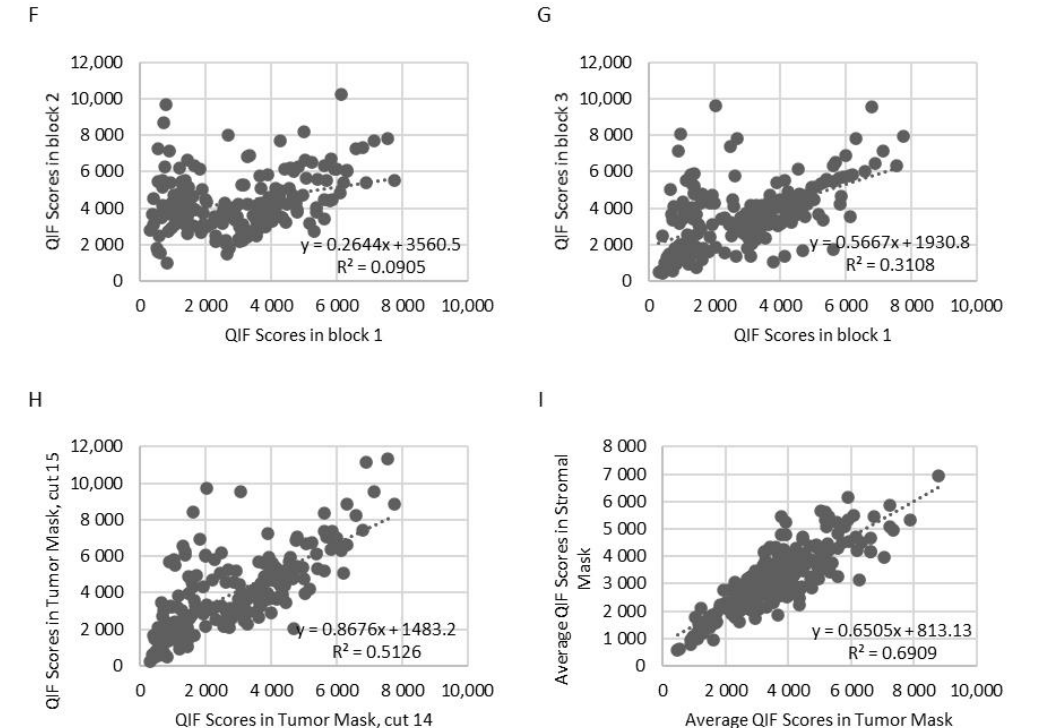
Figure 1. Patterns of expression and distribution of CD200 in lung cancer. ( A , B ) Dynamic range charts that depict CD200 expression within the tumor compartment in non-small cell lung cancer (NSCLC) ( A ) and large cell neuroendocrine carcinoma (LCNEC) ( B ) patients. Red lines represent the visual cutoffs that were used to define CD200 positive cases. ( C – E ) Different cores from the same representative NSCLC case, stained in YTMA423 blocks 1 ( C ), 2 ( D ) and 3 ( E ). ( F – I ) Scatter plots indicative of intratumoral heterogeneity of CD200 in NSCLC. Scatter plots of YTMA423 block 1 versus block 2 ( F ) and block 3 ( G ). Scatter plot between serial cuts of YTMA423 block 1 ( H ). Scatter plot between tumor and stromal expression of CD200 on the same cut ( I ). Abbreviations; DAPI, 4 ′ ,6-diamino-2-phenylindole; CK, Cytokeratin.